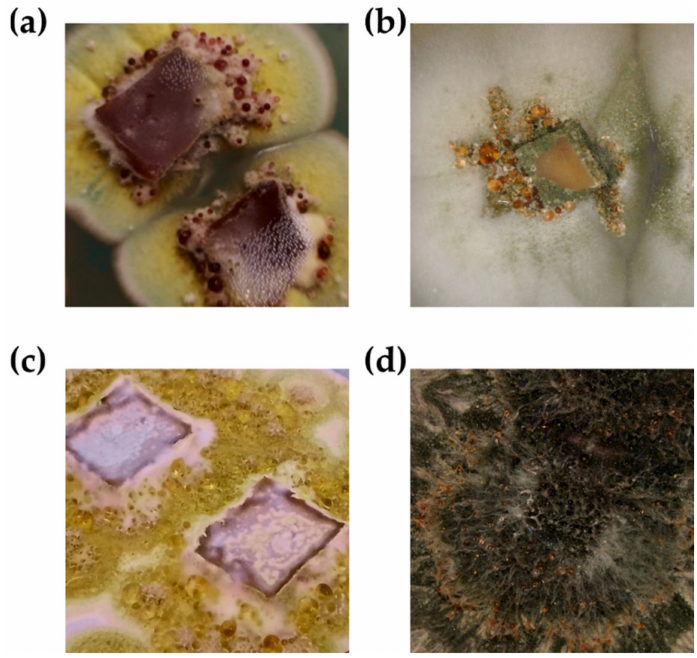
Figure 1. Fungal guttation—liquid droplets exuded on the fungi colony surface. ( a – c ) are the different strains belonging to Aspergillus genus; ( d ) strain belonging to Gliomastix